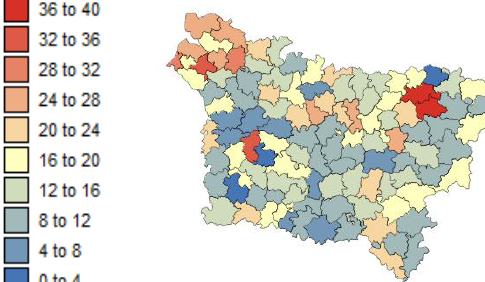
Figure 3. Maps of the lip, oral cavity and pharynx cancer mortality risk estimates and the corresponding prediction variance computed by Poisson kriging at three spatial scales: ( a ) county level; ( b ) grid level and ( c ) IRIS level.